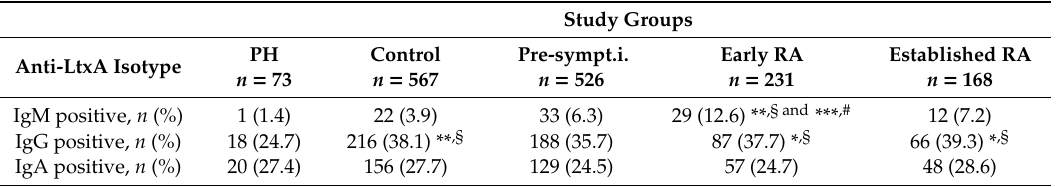
Table 1. Frequency of ever positive for anti-LtxA IgM, IgG and IgA in pre-symptomatic individuals, early rheumatoid arthritis (RA), established RA and periodontitis healthy